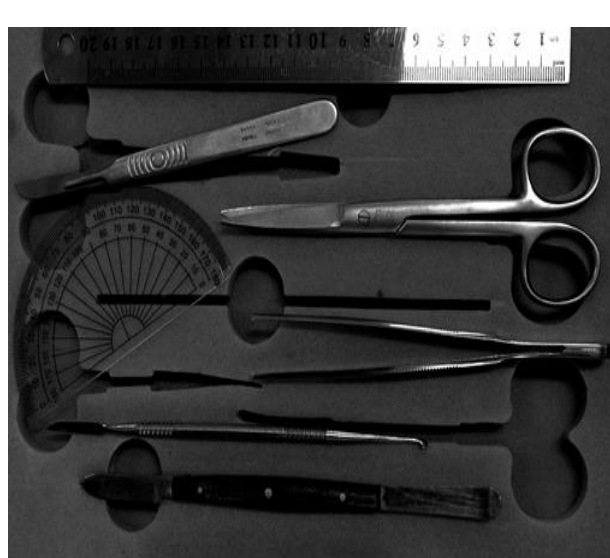
Figure 7. Dissection equipments The equipment; which used in the dissection were Dissection scissor, dissection scalpel, wax knife and dental lacrona (avoid the use of sharp dissection scalpel because they may distort the architecture of myocardium) (Figure 7) .Starting by the removal of atria, parts of aorta and pulmonary artery (in order to expose the ventricles only) by using dissection scissor then remove the visceral-pericardium and pericardial-fat by using wax knife and dental lacrona (in order to expose the ventricular myocardium) (Figure 8).By simple boiling with distilled water approximately 1-3h .according to the size of the heart (1-1.5h for fish, chicken, small sheep and goat heart and 2.5-3h for cow, large sheep and goat heart). The method of simple boiling is the same method that used by Torrent-Guasp. (16) Carrying out the heart from the boiled water into a thick peace of paper in order to get dry (this will make the opening-technique easier).By using the dissection scalpel make a transverse section passing throw the base of the heart, now you are able to visualize the cavity of each ventricle; where each surrounds by its wall, if you look closely to the wall of each ventricular cavity you will visualize that the right ventricle wall is represented by a single relatively thin layer in contrast to left ventricle wall which represented by a deep thick layer covered with a thin layer (Figure